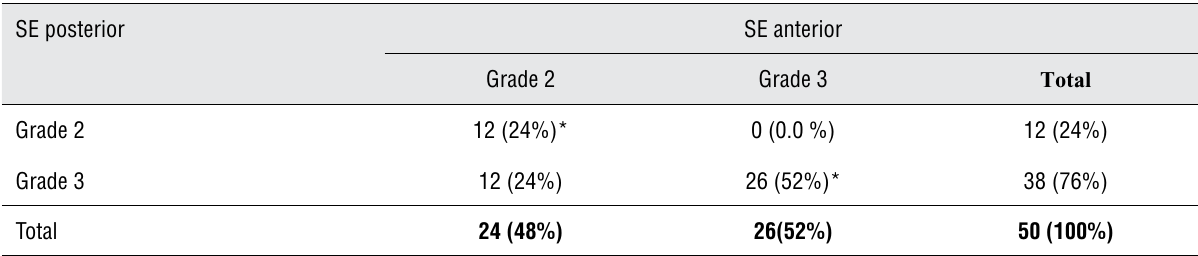
Table 1 - Association between the bidigital vaginal palpation in anterior and posterior areas of vaginal introitus according to Amaro’s classification (4).